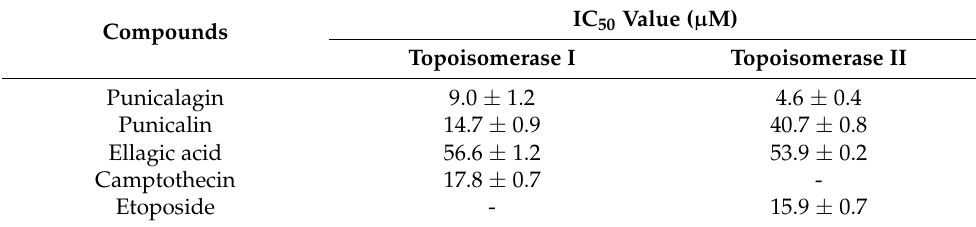
Table 4. Activity of punicalagin, punicalin, ellagic acid, and reference compounds on topoisomerase I and topoisomerase II from Candida albicans . The IC 50 values are expressed as mean ± SD ( µ M).